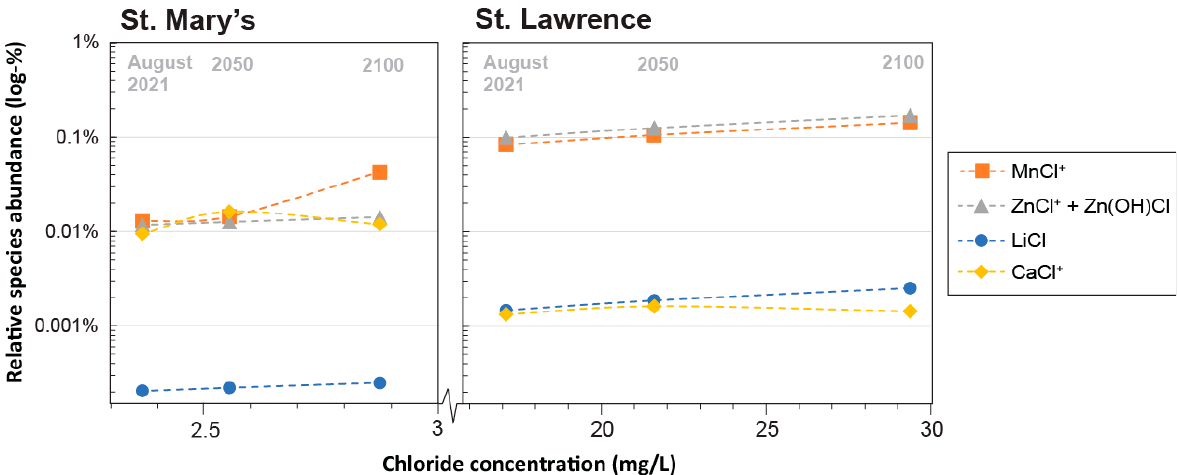
Figure 4. Geochemical equilibrium modelling of the relative abundance of select aqueous Cl- complexes of Mn, Zn, Li and Ca in the St. Marys (upstream, left panel) and St. Lawrence (downstream, right panel) rivers in the Great Lakes basin. Plotted is the share of select individual aqueous species per-total (molality basis, logarithmic y-axis) as a function of Cl concentration (intersected x-axis).